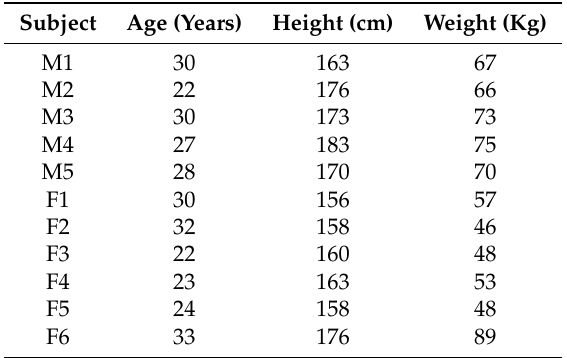
Table 1. Characteristics of the participants of this